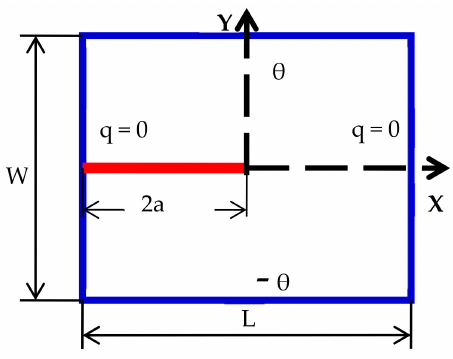
Figure 14. Edge crack (b) geometry and the boundary conditions of a square plate with an edge crack.